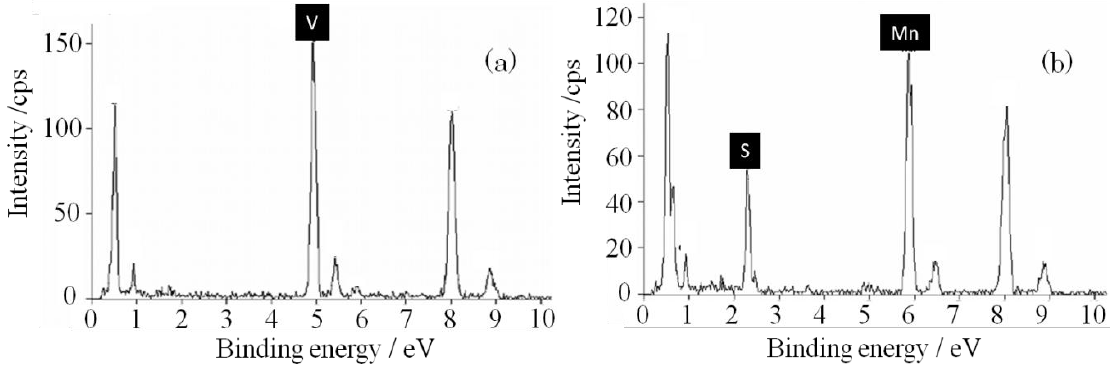
Figure 6. Energy dispersive X-ray spectrometry (EDX) at ( a ) Point 1; and ( b ) Point